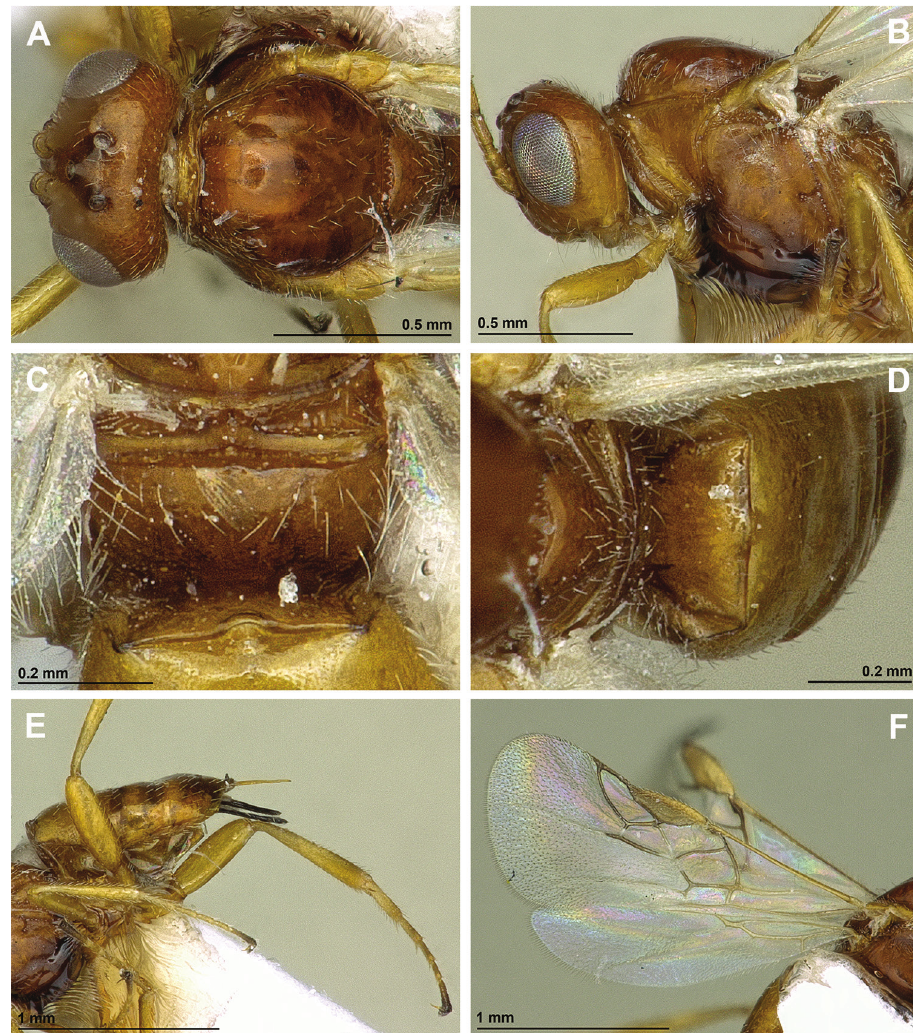
Figure 2. Hoplocrotaphus hamooniae sp. n. (female, holotype) A Head and mesoscutum, dorsal view B Head and mesosoma, lateral view C Propodeum, dorsal view D First metasomal tergite E Legs, metasoma and ovipositor, lateral view F Fore and hind